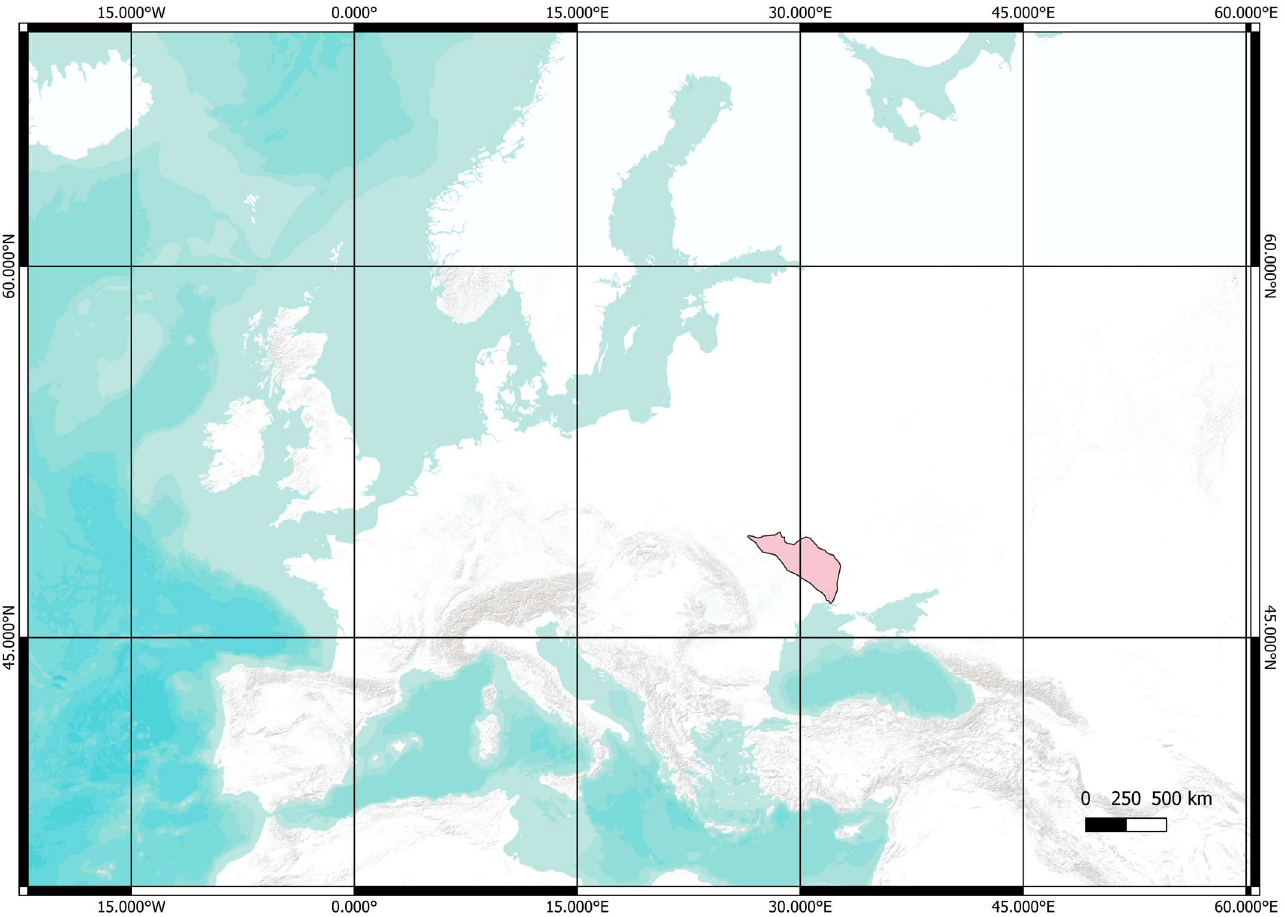
Figure 1. The Southern Buh catchment (pink area) on the map of Europe. Topo—ESRI Terrain. Elaboration—DK.